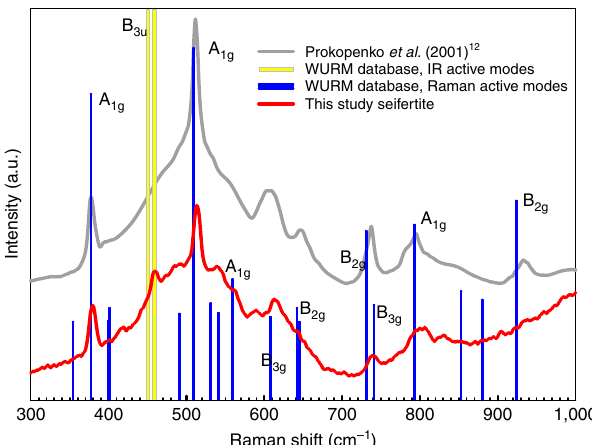
Figure 5 | Raman spectrum of seifertite. Sample from this study, quenched from 50GPa (red line), collected outside the diamond-anvil cell (Dilor XY spectrometer, excitation wavelength 514nm; power 0.7W, acquisition time 120s repeated three times). For comparison, we also plot previous experimental 12 (grey line) and computational 28 (labelled blue bars) Raman spectra of seifertite.